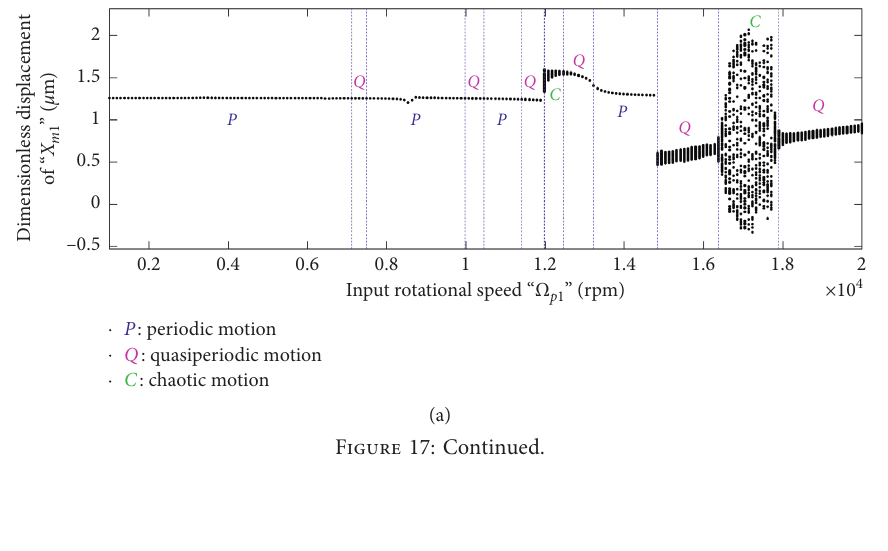
� s � 60 μ m . (a) X 1 2